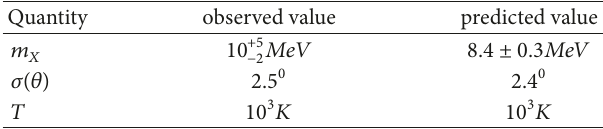
Table1:Valuesofthedarkmatterparticlemass 𝑚 𝑋 ,thetemperature of the 𝛾− ray source T, and its angular radius 𝜎(𝜃). The ”observed” values are based on either direct observations or fits to the data, and the predictions follow from the 𝑍󸀠 𝑒 /𝑍󸀠 ] mediated reaction model as discussed in